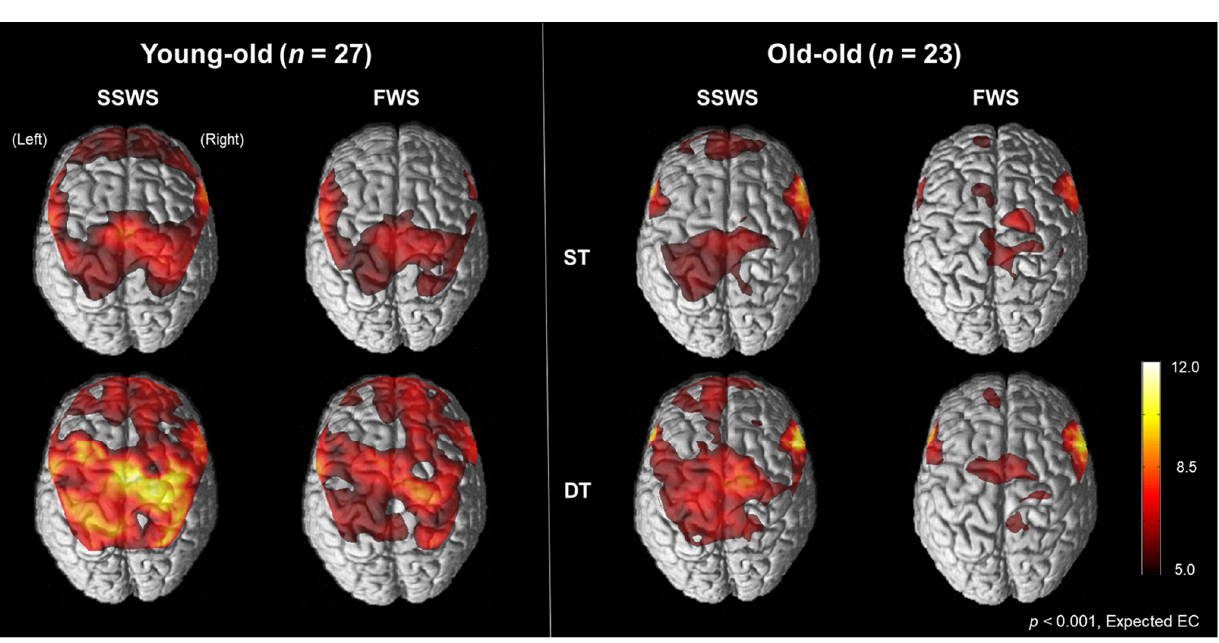
Figure 2. Cortical activation patterns during walking in the young-old and the old-old. Cortical activities measured by oxyHb concentration were increased during dual-task walking compared with single-task walking but decreased during fast-walking speed compared with self-selected walking speed in the bilateral M1-leg, SMA, and dlPFC in both the young-old and the old-old elderly. ST, single-task; DT, dual-task; SSWS, self-selected walking speed; FWS, fast walking speed.